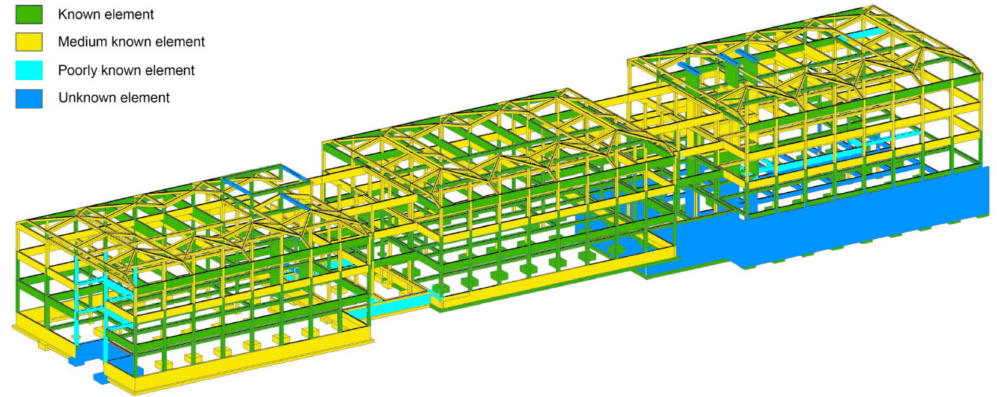
Figure 10. Mapping of the overall level of knowledge of a building